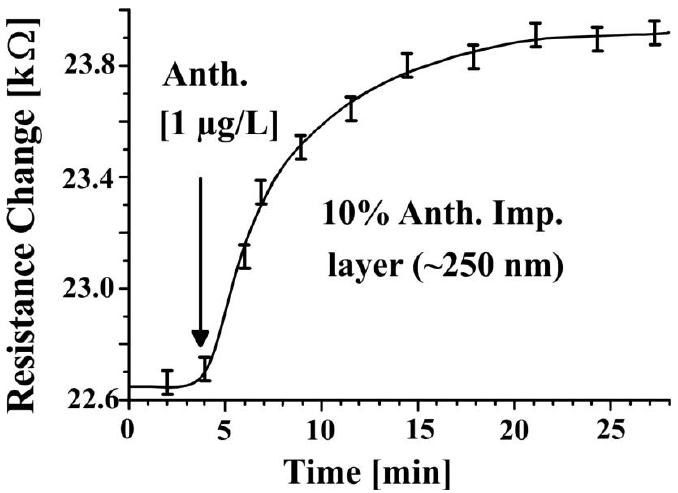
Figure 3. The resistance of 10% anthracene imprinted polyurethane layer (coated on IDT) measured with LCR meter at a frequency of 1 kHz while exposing to its template analyte solution. The resistance of layer increases with time due to blocking of diffusion channels.